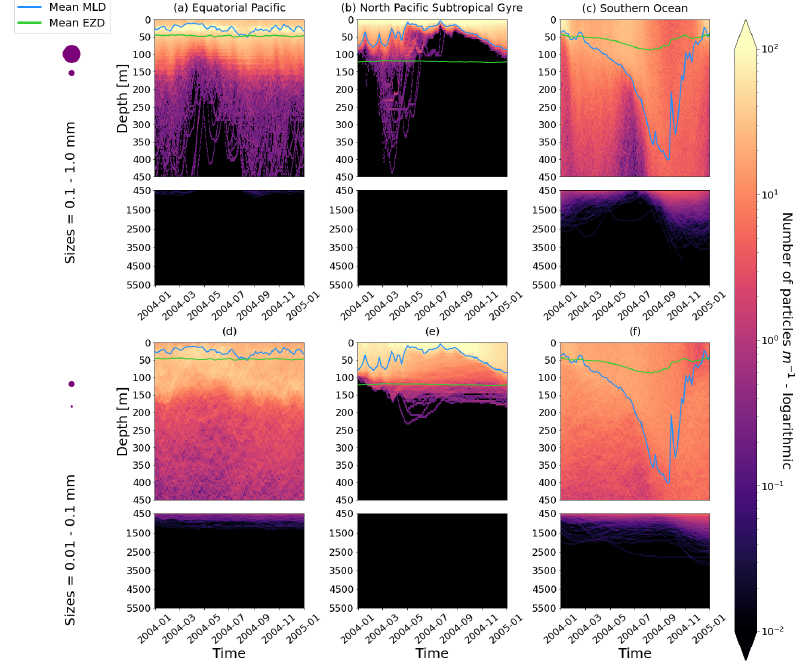
Figure C2. As in Fig. 2 but for particles with an initial density of 1020kgm − 3 , representing rigid polyamide.